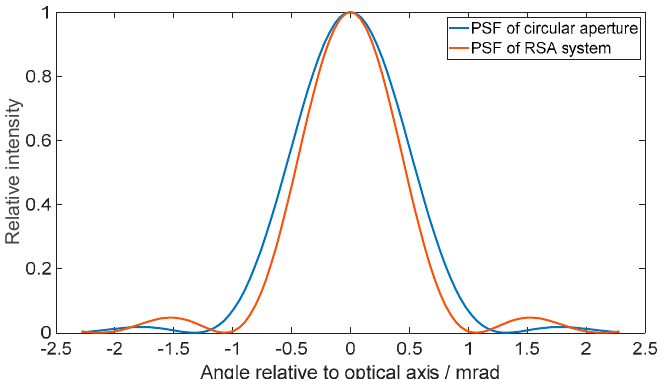
Figure 4. Sections of the PSF of a 0.5 m circular aperture (blue curve) and the PSF of a 5:1 aspect ratio, 0.5 m long rectangular aperture (orange curve).